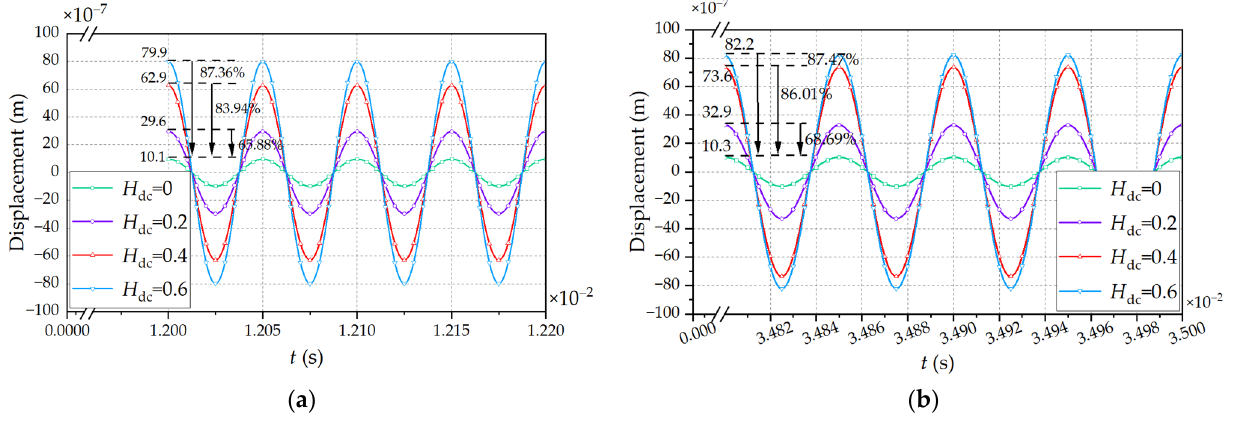
Figure 14. Winding deformation characteristics. ( a ) Interleaved windings; ( b ) Continuous windings.